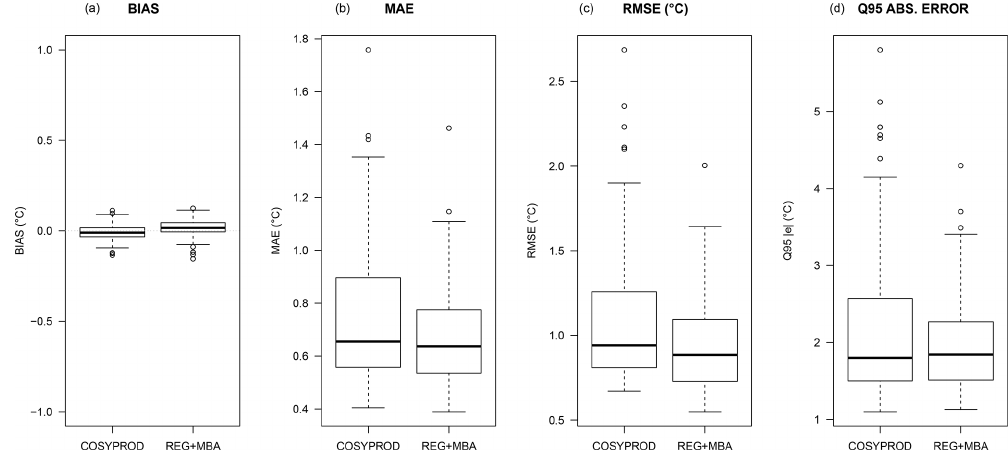
Figure 8. Boxplots of bias (a) , mean absolute error (b) , root mean square error (c) and 0.95 quantile of absolute error (d) for COSYPROD (left boxplot) and the new method (right